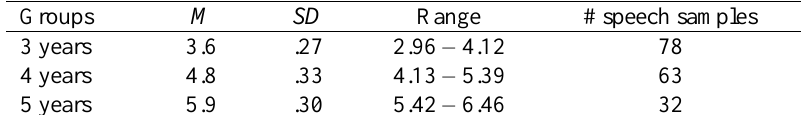
Table 1. Mean age ( M ), standard deviation ( SD ), range, and number of speech samples ( N = 173) in the three age groups used to construct the Viana